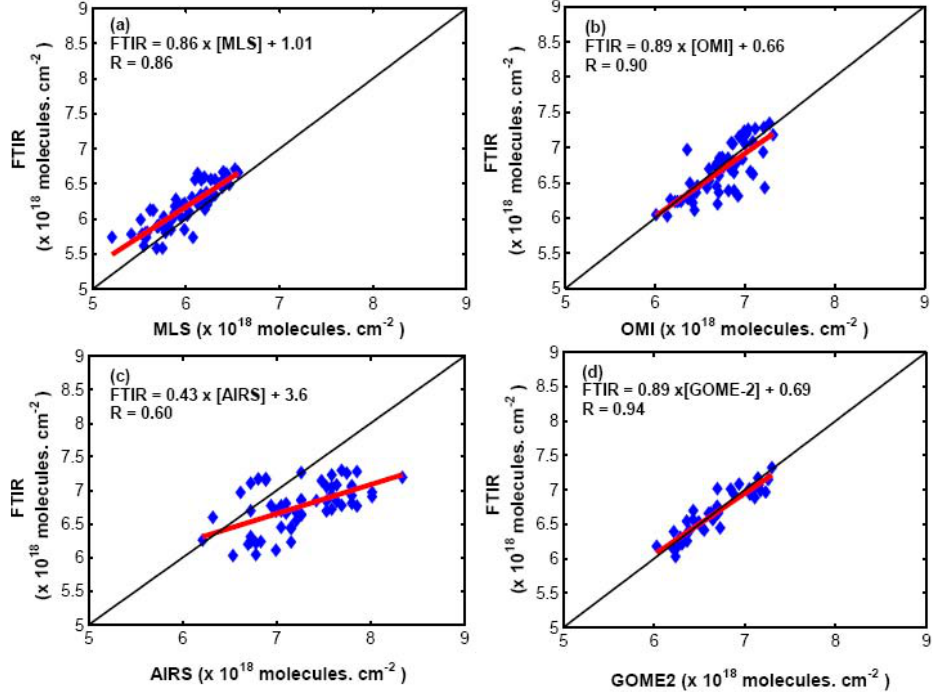
Fig. 9. Scatter plot of columns amount of O 3 measured by ground-based FTIR versus those observed by MLS, OMI, AIRS and GOME-2. In all panels, the red line shows linear fit line of the data pairs that are intercompared. The slope and “R” for the comparisons are also shown in the panels. The black solid line shows the one-to-one line of 100%